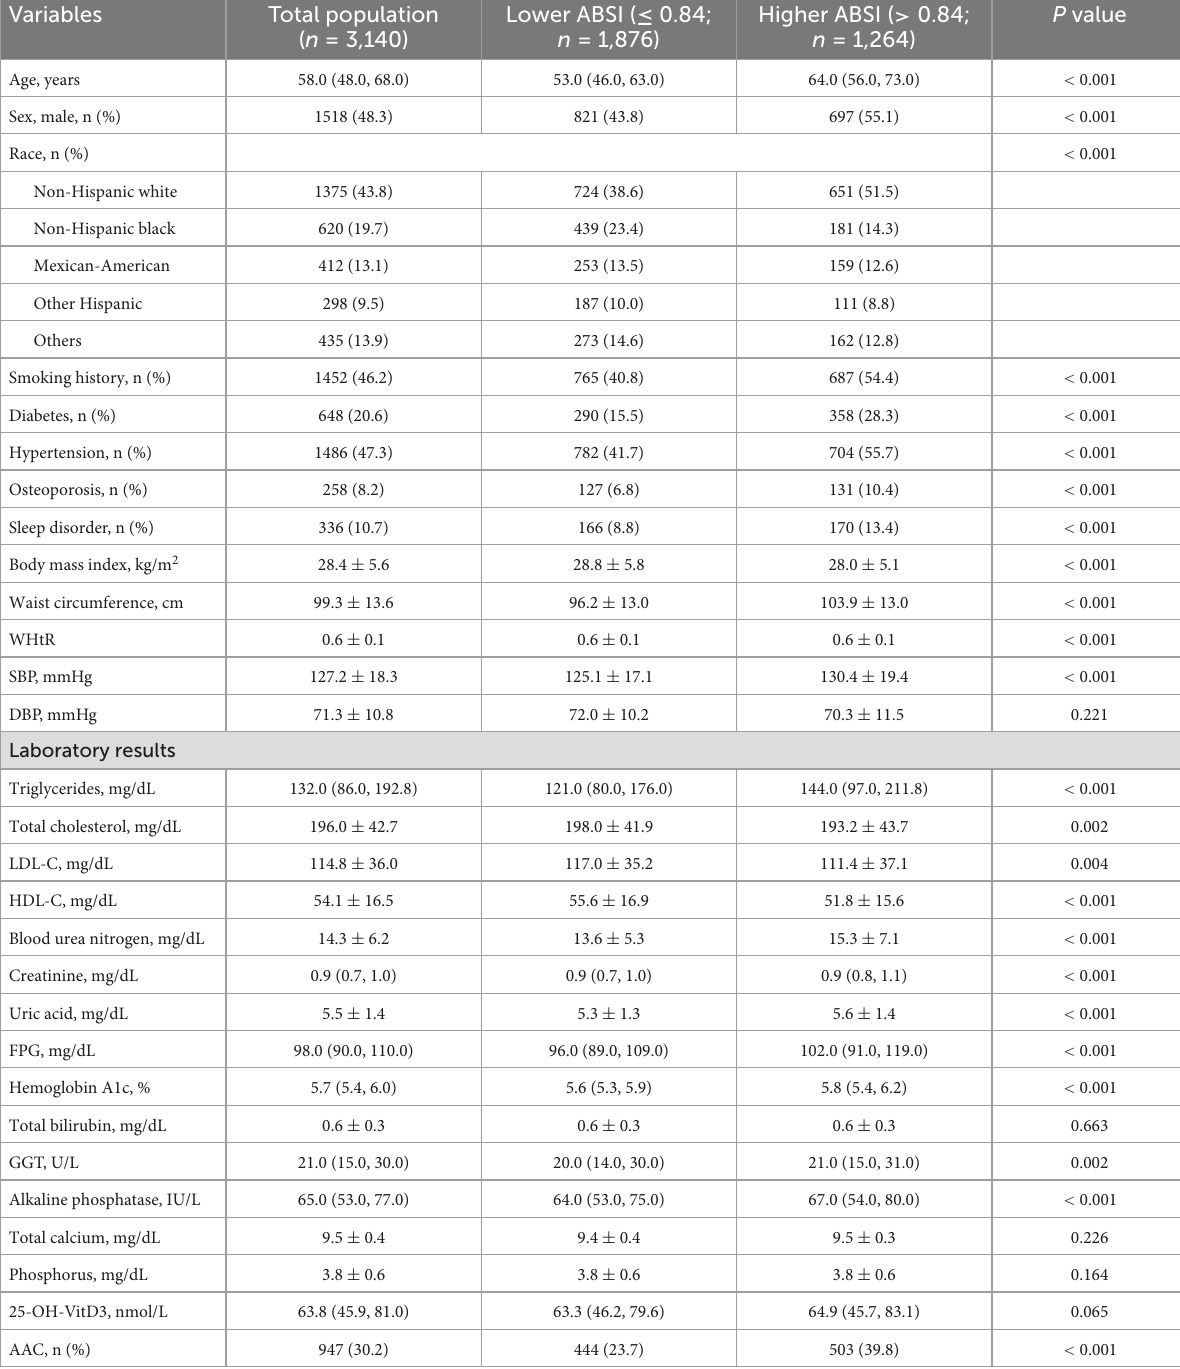
TABLE 1 Participants characteristics stratified by the optimal cutoff point of a body shape index (ABSI).